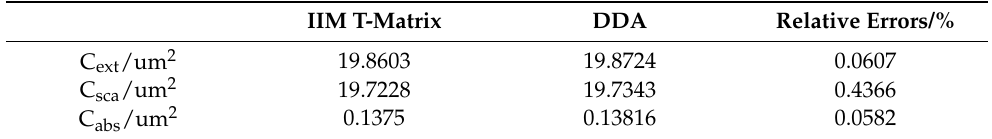
Table 3. The integral scattering properties of the octagonal prism particles calculated by IIM T-matrix and DDA